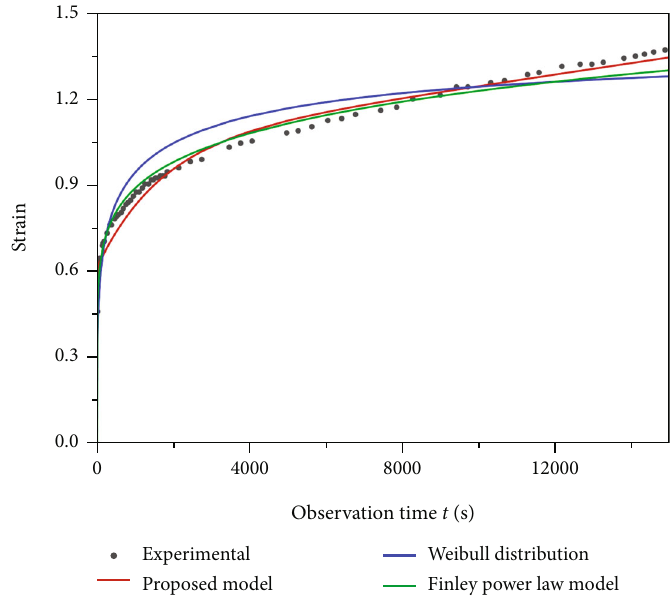
Figure 9: Model validation for creep time 250 min: Finley and Weibull models vs. the proposed model for